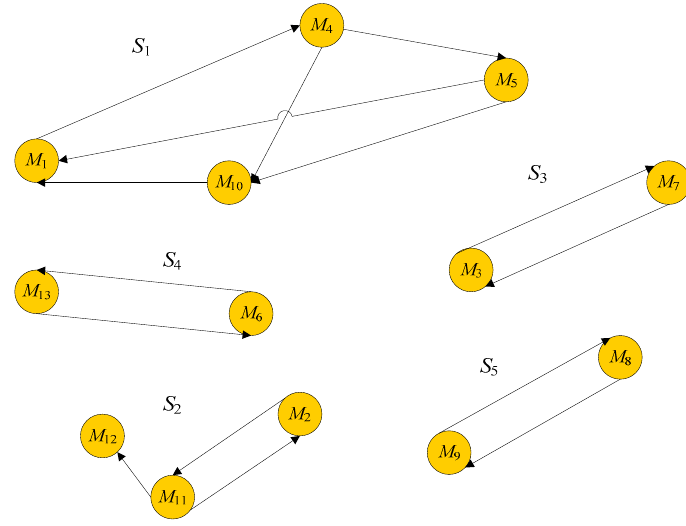
Figure 5. Subsystem division of the target CNC machine tool.